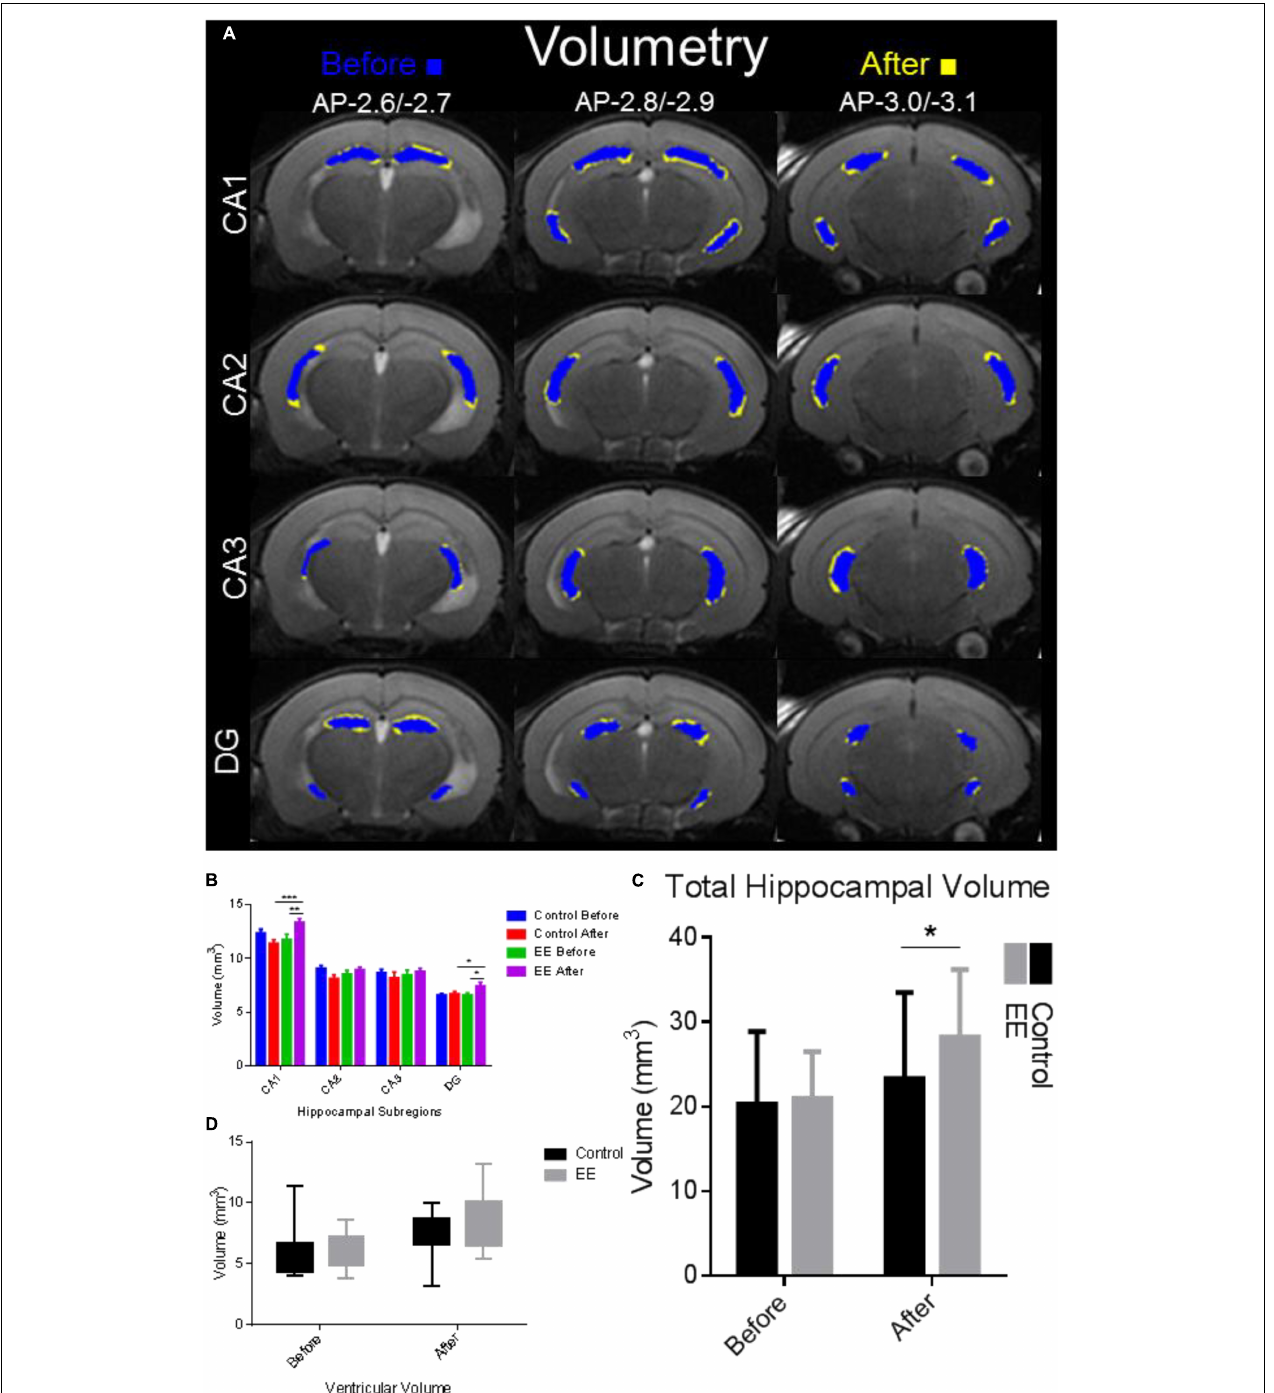
FIGURE 2 | Hippocampal complex volume alterations due to environmental enrichment. (A) Volumetry for hippocampal subdivisions. Blue indicates the time point before and yellow indicates the time point after 30 days of EE and SE. The hippocampal complex was delineated manually using the T2 image map from slices AP-2.6/–2.7, AP-2.8/–2.9 to AP-3.0/3.1 (first, second, third rows, respectively; Franklin and Paxinos, 2008). The volume (in mm 3 ) of each hippocampal subdivision was determined and compared with the time points before and after in the EE group and SE control group. (B) Volume delineations from the hippocampal subdivisions in mm 3 . CA1 volume was significantly increased for the after-EE time point compared with the before EE time point (*** p < 0.001), in addition to the control before/after time points (** p < 0.01). DG volume was significantly increased for the after-EE time point compared with the before-EE time point (* p < 0.05), in addition to the control before/after time points (* p < 0.05). (C) Total hippocampal volume was significantly increased in the after-EE group compared with the SE control group (* p < 0.05). (D) Ventricular volume was enlarged in the after-EE group, although insignificantly compared with the after-SE control group.